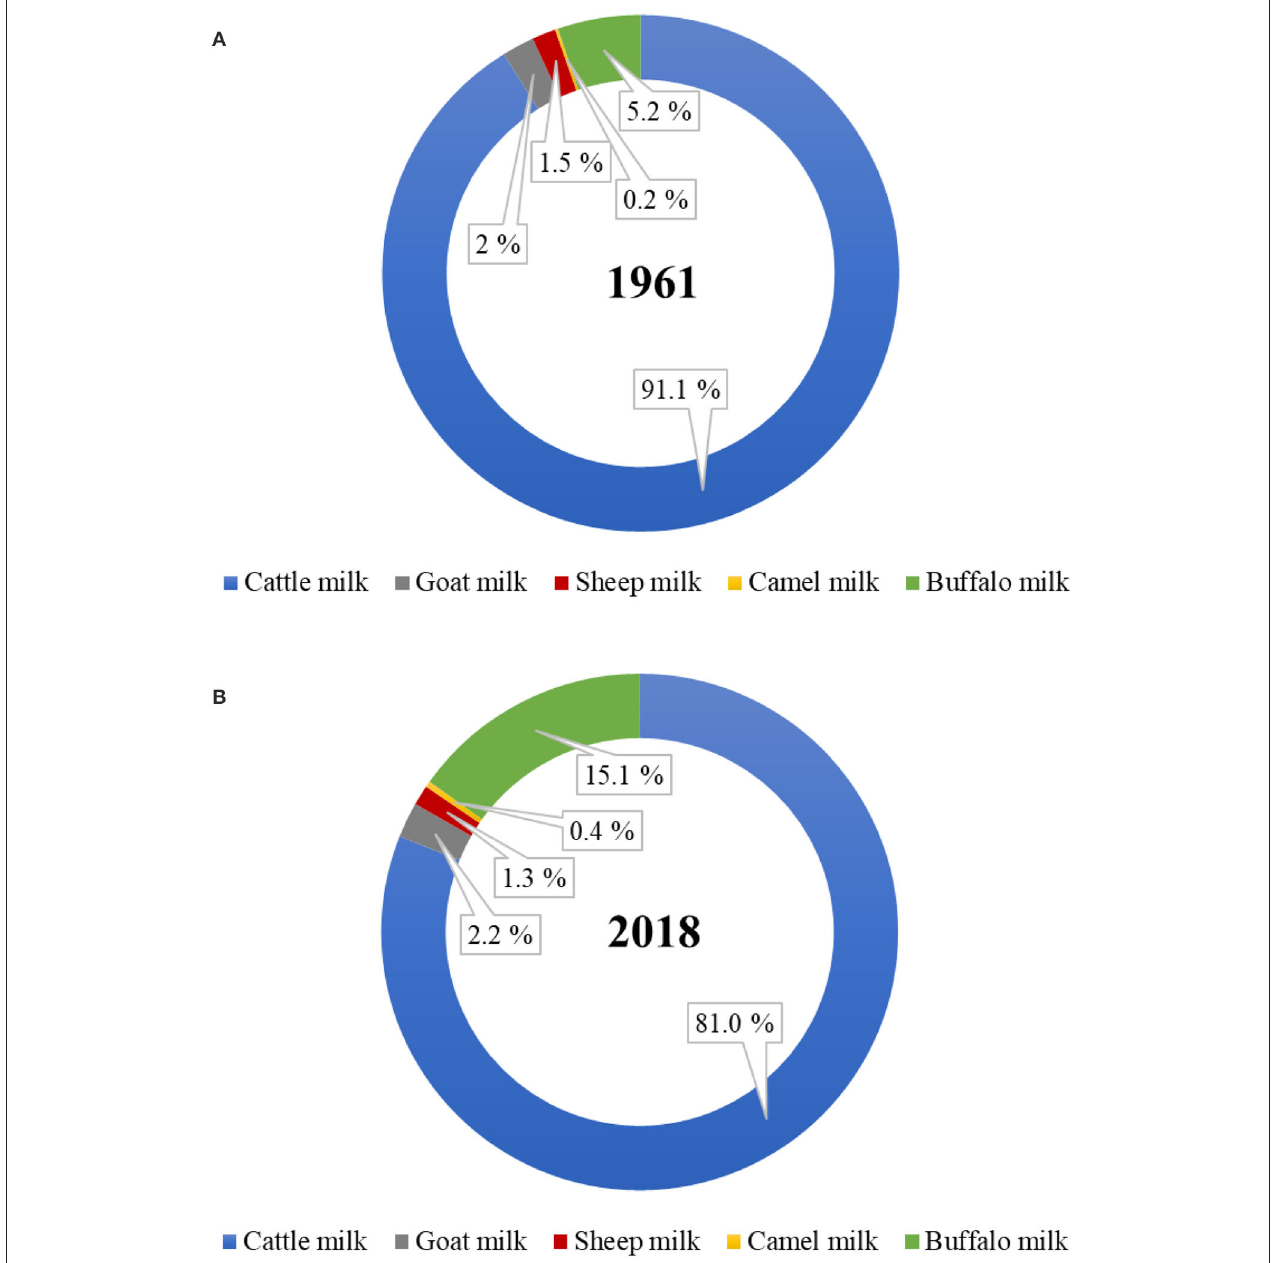
FIGURE 1 | Proportion of dairy cattle and non-cattle milks produced globally in the year (A) 1961 and (B) 2018. ( Source: FAOstat, March